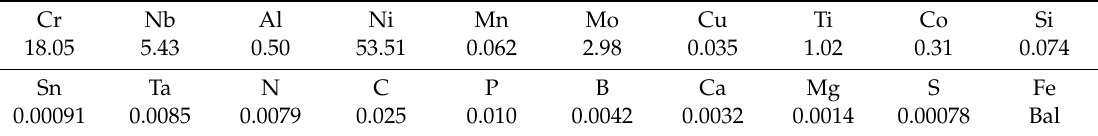
Table 1. Chemical composition of the material (% wt) [22].